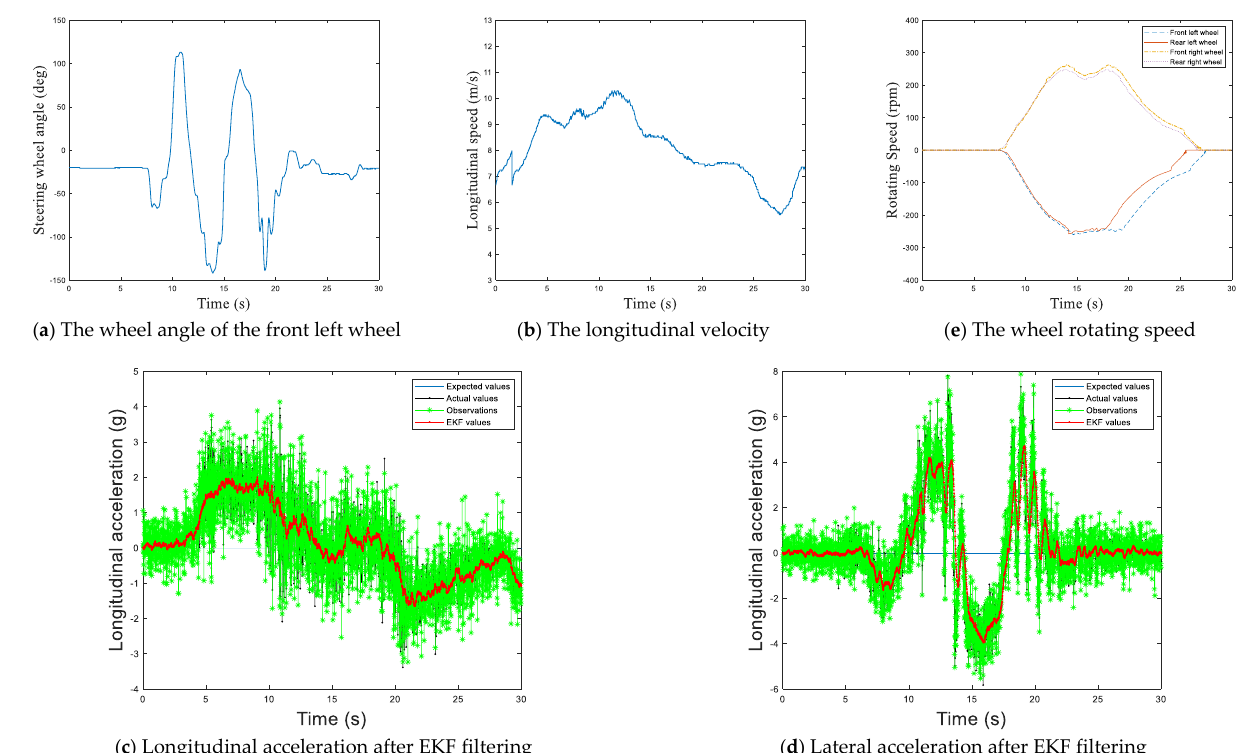
Figure 16. Due to the large measurement noise in IMU, the measured longitudinal accel-